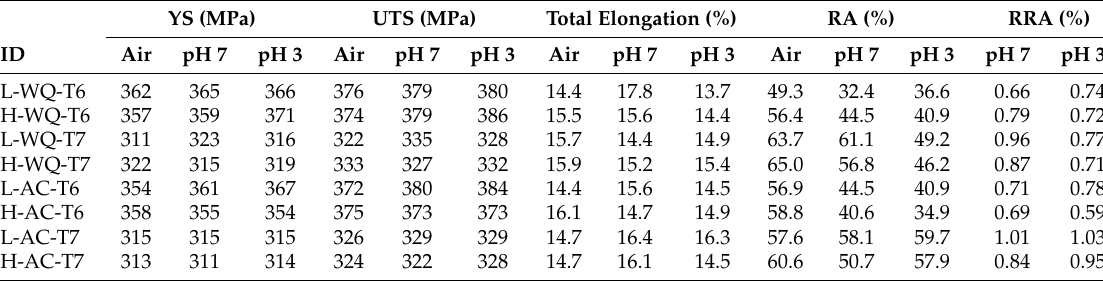
Table 4. Results from SSRT in air and 3.5 wt.% NaCl with pH 7 and pH 3. The yield strength (YS), ultimate tensile strength (UTS), total elongation, and reduction in area (RA) are given. The reduction in area ratio (RRA) are calculated based from the RA values and they demonstrate less change for the T7 tempers.